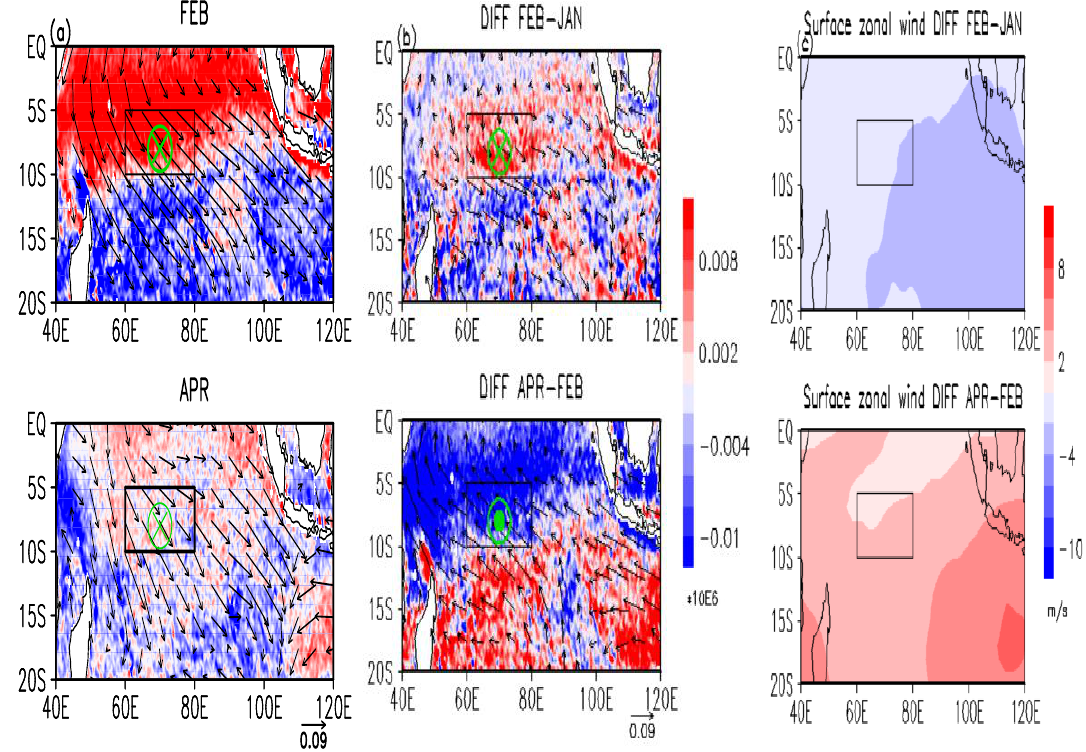
Figure 7. Wind stress and wind stress curl anomalies. ( a ) Monthly mean wind stress (vector) and wind stress curl anomalies (shaded) in February and April from 2008 to 2014. ( b ) Differences in wind stress and wind stress curl anomalies as February minus January and April minus February, respectively. (Unit: N/m 2 ; N/m 3 ). ( c ) Differences in the surface zonal wind (10m) obtained from ERA-interim difference as February minus January and for April minus February, respectively (Unit: m/s). [The boxes in black line are the SSSAs ESF area in the southern Indian Ocean( 60° E – 80° E, 5° S – 10° S); the green plus mark represents downwelling and the green closed circle represents upwelling ].